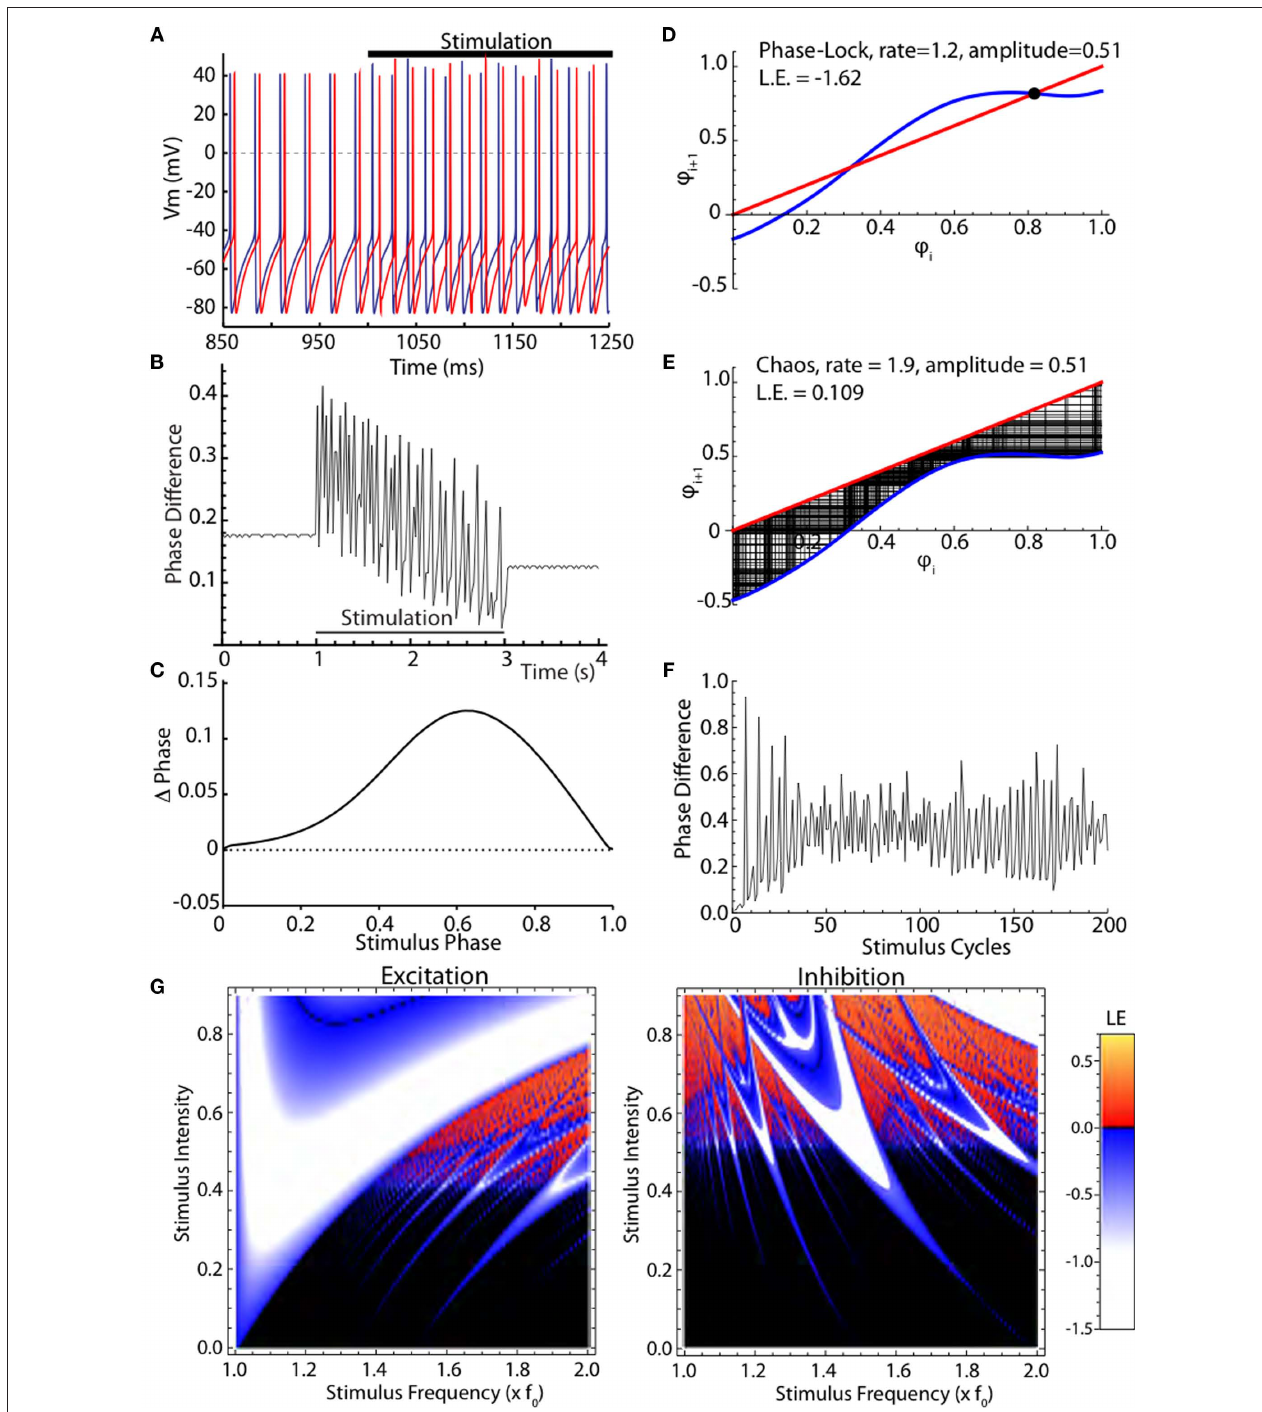
phases. (F) Phase differences for two initially nearby trajectories in the chaotic map. ( g) Map of stimulus strength and frequency dependence of firing patterns using the Lyapunov exponent. Negative Lyapunov exponents (white to blue) indicate phase convergence and synchrony. Positive Lyapunov exponents (red to orange) indicate chaotic phase divergence. Lyapunov exponents near zero, indicating neither active synchronization nor desynchronization, are shown black. Inhibitory current pulses also produce chaotic firing and divergence of trajectories, but over a different range